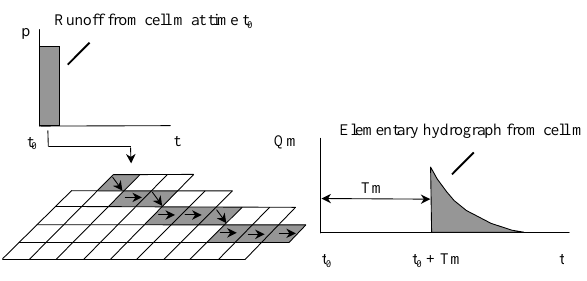
Fig. 2. Routing model operating for each mesh of the basin. Figure 2: Routing model for each mesh of the basin 12